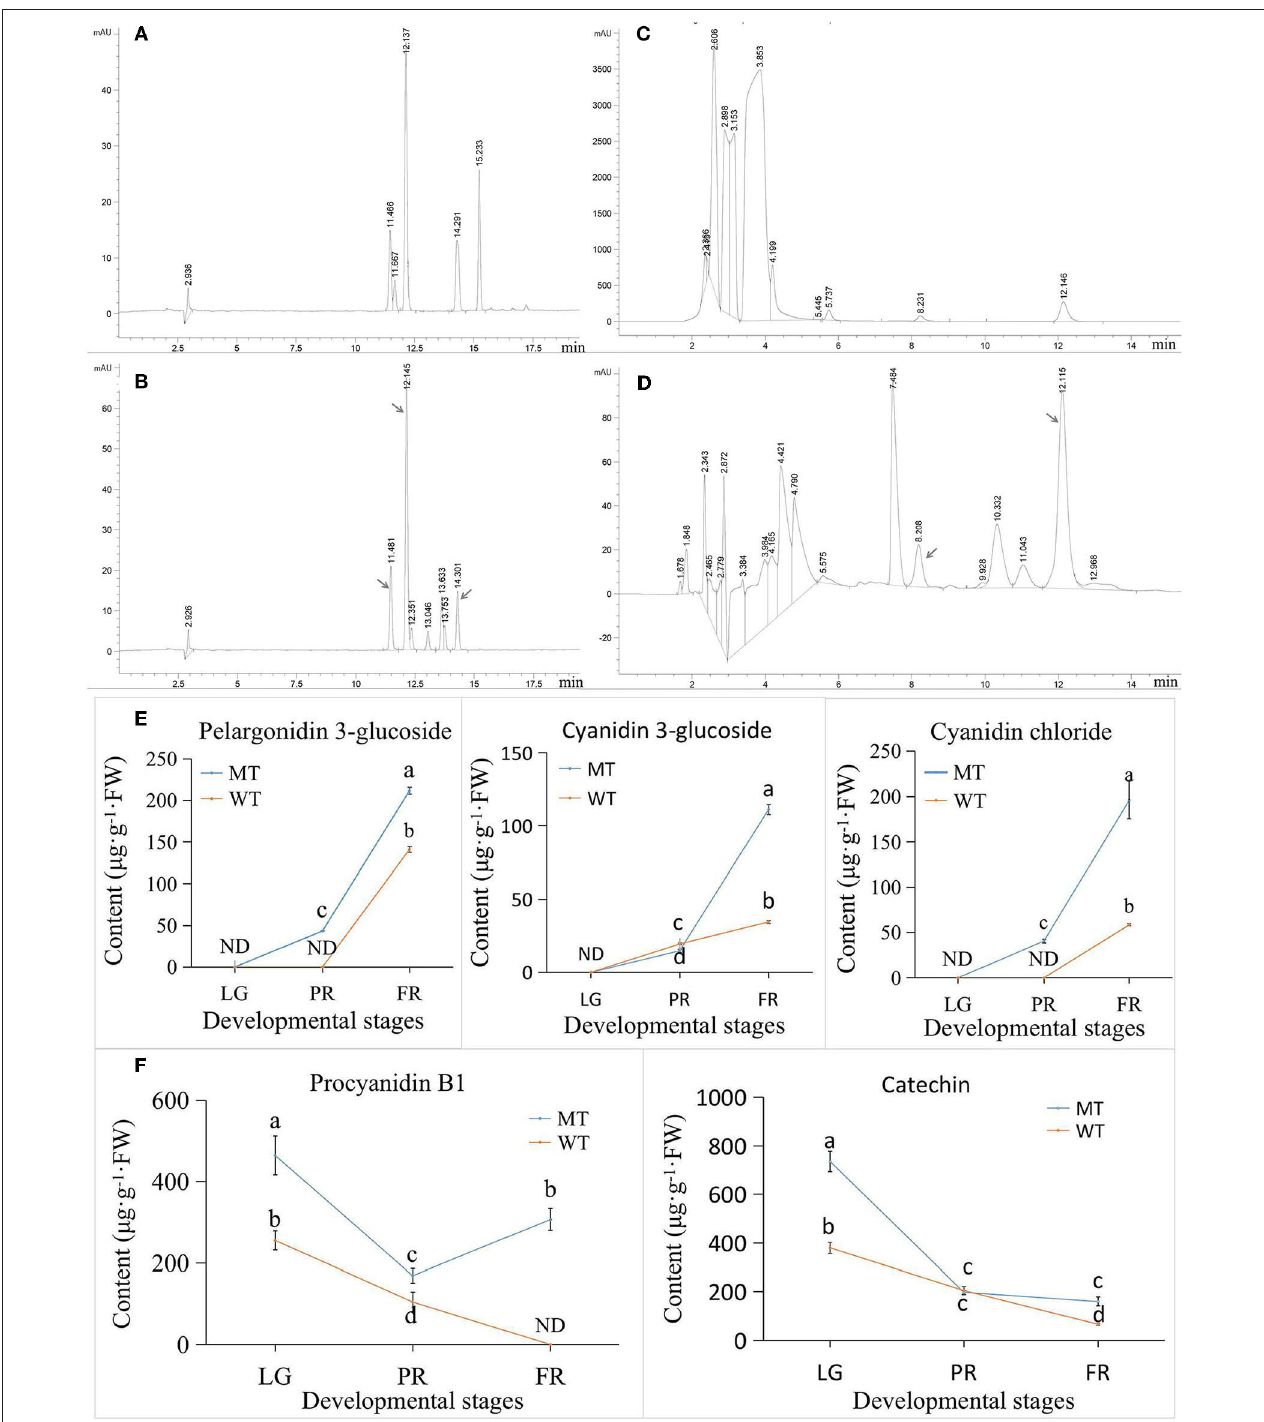
FIGURE 6 | The HPLC analysis of selected anthocyanins and PAs in strawberry. (A) HPLC peaks of five anthocyanins standards. Five peaks with retention time of around 11.4, 11.6, 12.1, 14.3, and 15.2min indicated cyanidin 3-glucoside, cyanidin 3- O -rutinoside, pelargonidin 3-glucoside, cyanidin chloride, and pelargonidin chloride, respectively. (B) The HPLC analysis of anthocyanins in strawberry samples. The peaks of corresponding anthocyanins were pointed by arrows. (C) The HPLC peaks of 2 PAs standards. The peaks at retention time 8.2 and 12.1min were procyanidin B1 and catechin, respectively. (D) The HPLC analysis of PAs in strawberry samples. The peaks of corresponding PAs were pointed by arrows. (E) The content of HPLC detected anthocyanins. (F) The content of HPLC detected PAs. ND, not detected; MT, mutant fruits; WT, normal ‘Benihoppe’ fruits; LG, large green stage; PR, partial red stage; FR, fully red stage.